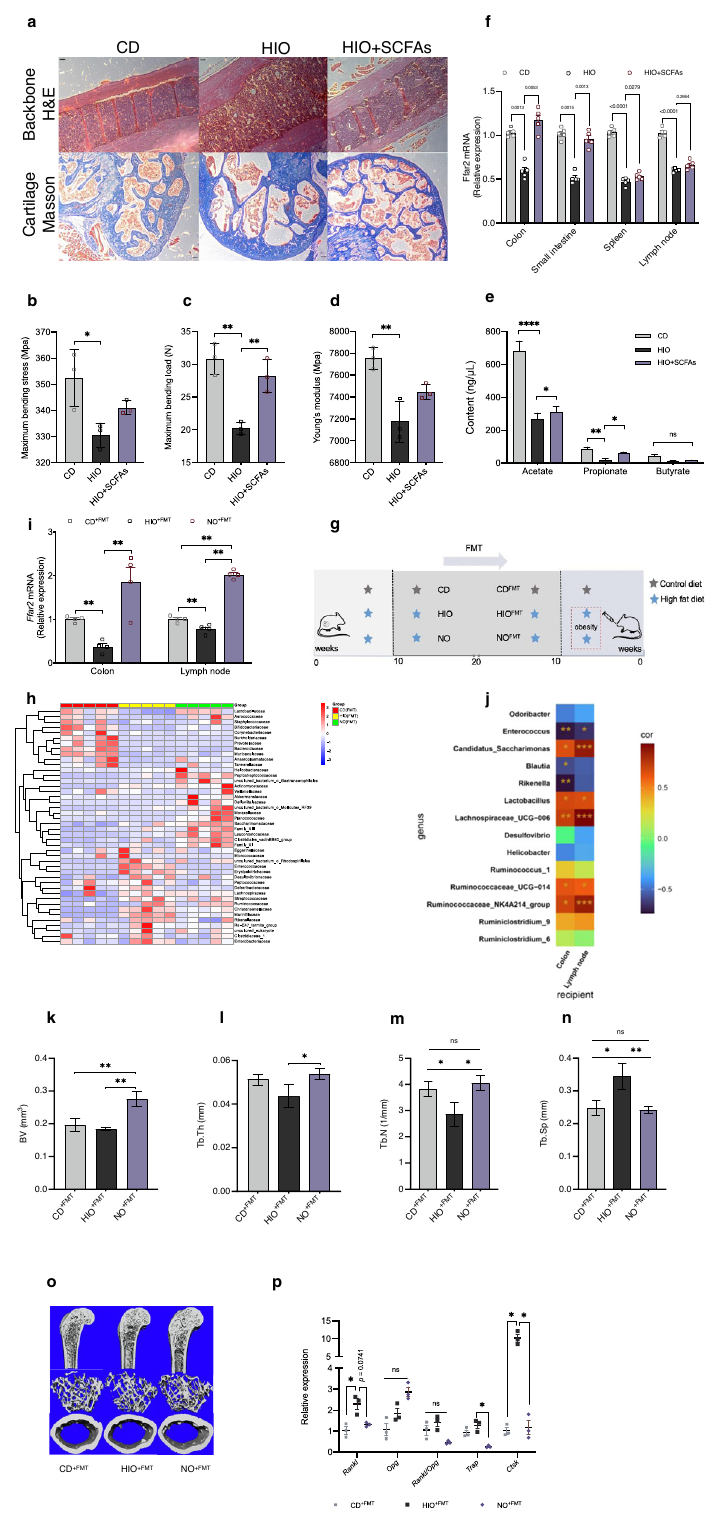
Il10 , a marker for bone OC differentiation, were increased in the lymph nodes (Fig. 6c). Of note, TGF- β 1 showed no signi fi cant change (Fig. S4l). Overall, the Tregs immune response via IL-10 related to NO gut microbiota transplantation not only affected the